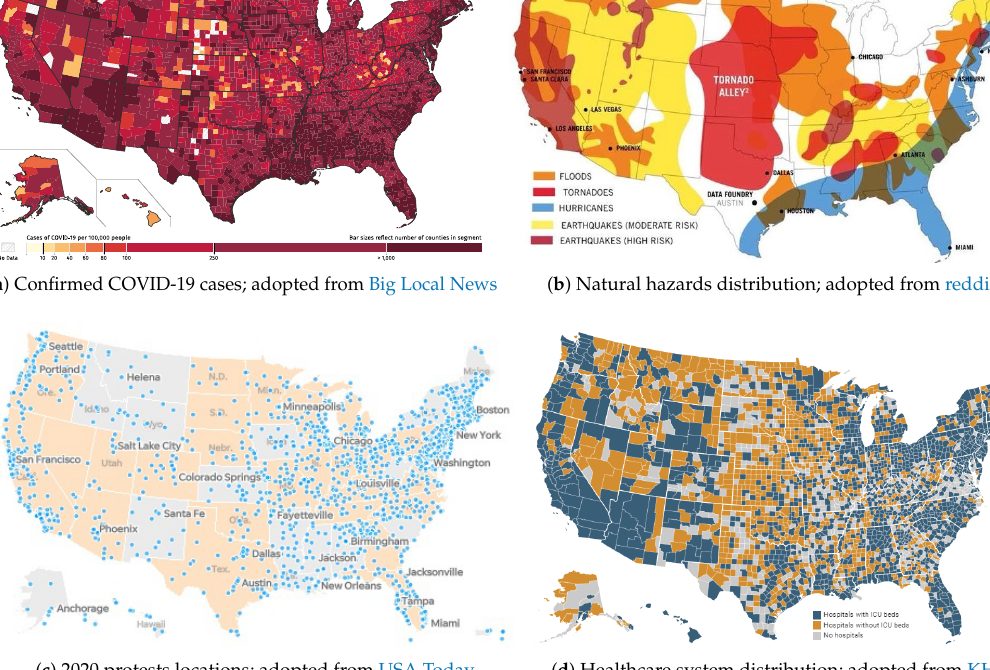
Figure 2. Spatial distribution of risk of exposure (pandemic), potential natural hazard, and mass gathering (of protests) across the U.S.; all maps are approximate and for illustration purposes